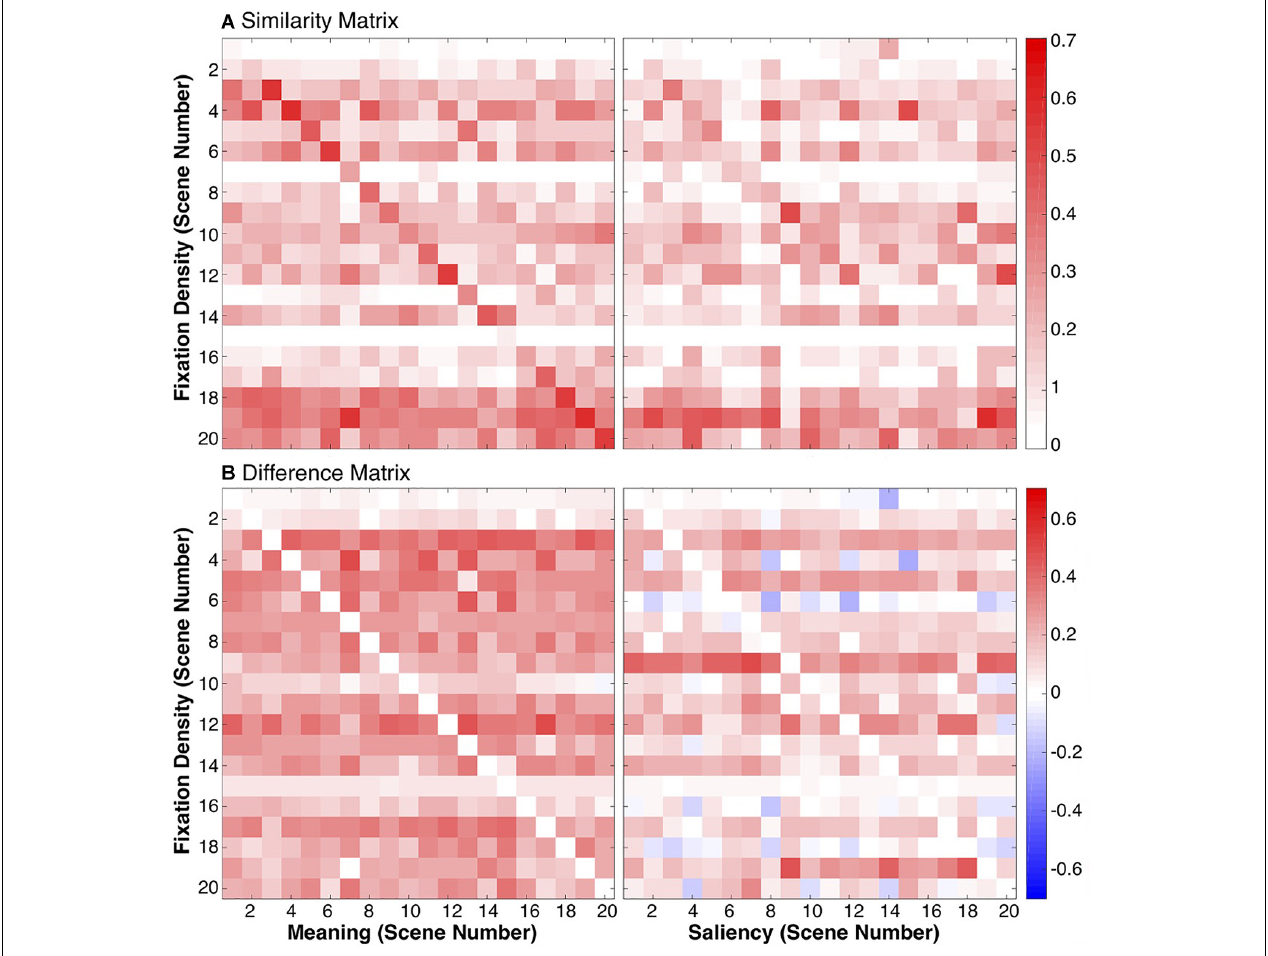
FIGURE 7 | Similarities between meaning/saliency maps and fixation densities. The similarity matrices (A) show the squared linear correlations between fixation densities and meaning/image salience maps for each scene combination. The difference matrices (B) show the difference between the correlations of fixation densities and meaning/saliency for the same scene and correlations of fixation densities and meaning/saliency from different